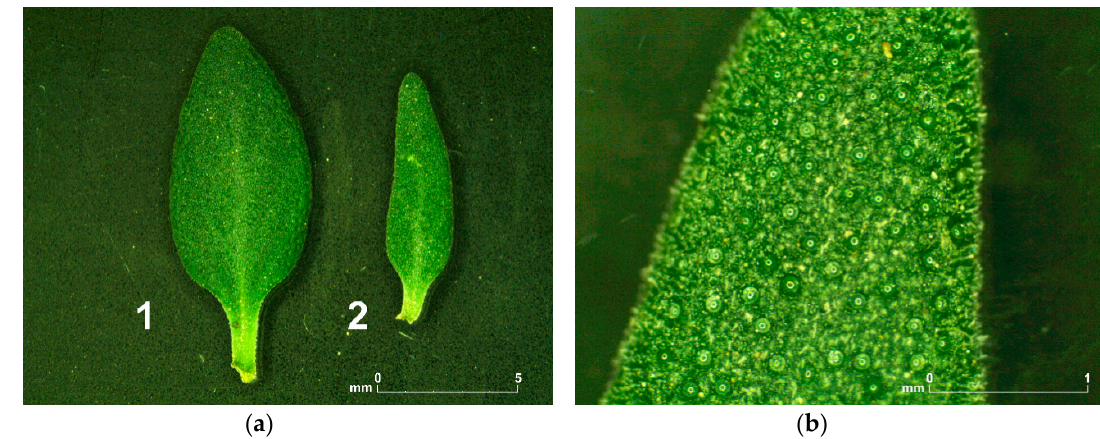
Figure 2. ( a ) Shape of leaves: 1–oblong-obovate; 2–lanceolate; ( b ) Glandular trichomes on the adaxial leaf surface.